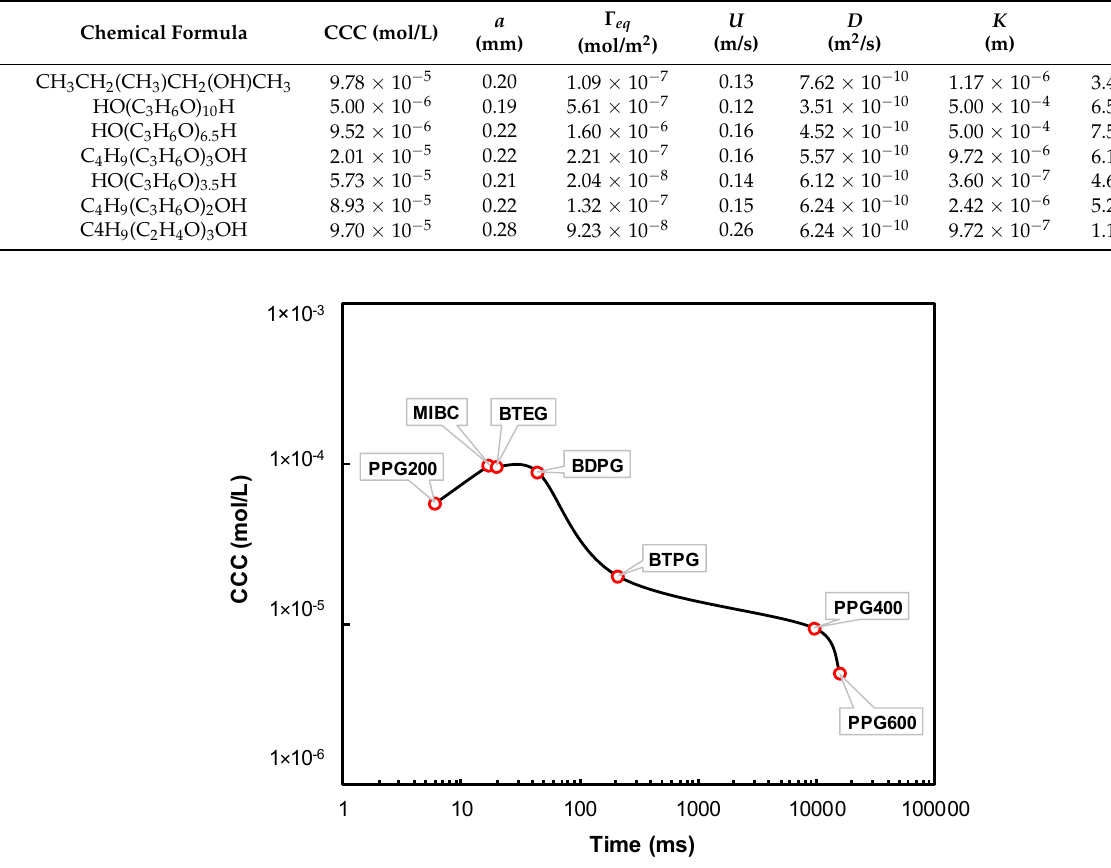
Figure 8. Correlation between CCC values of the frothers and time for reaching adsorption equi- librium.